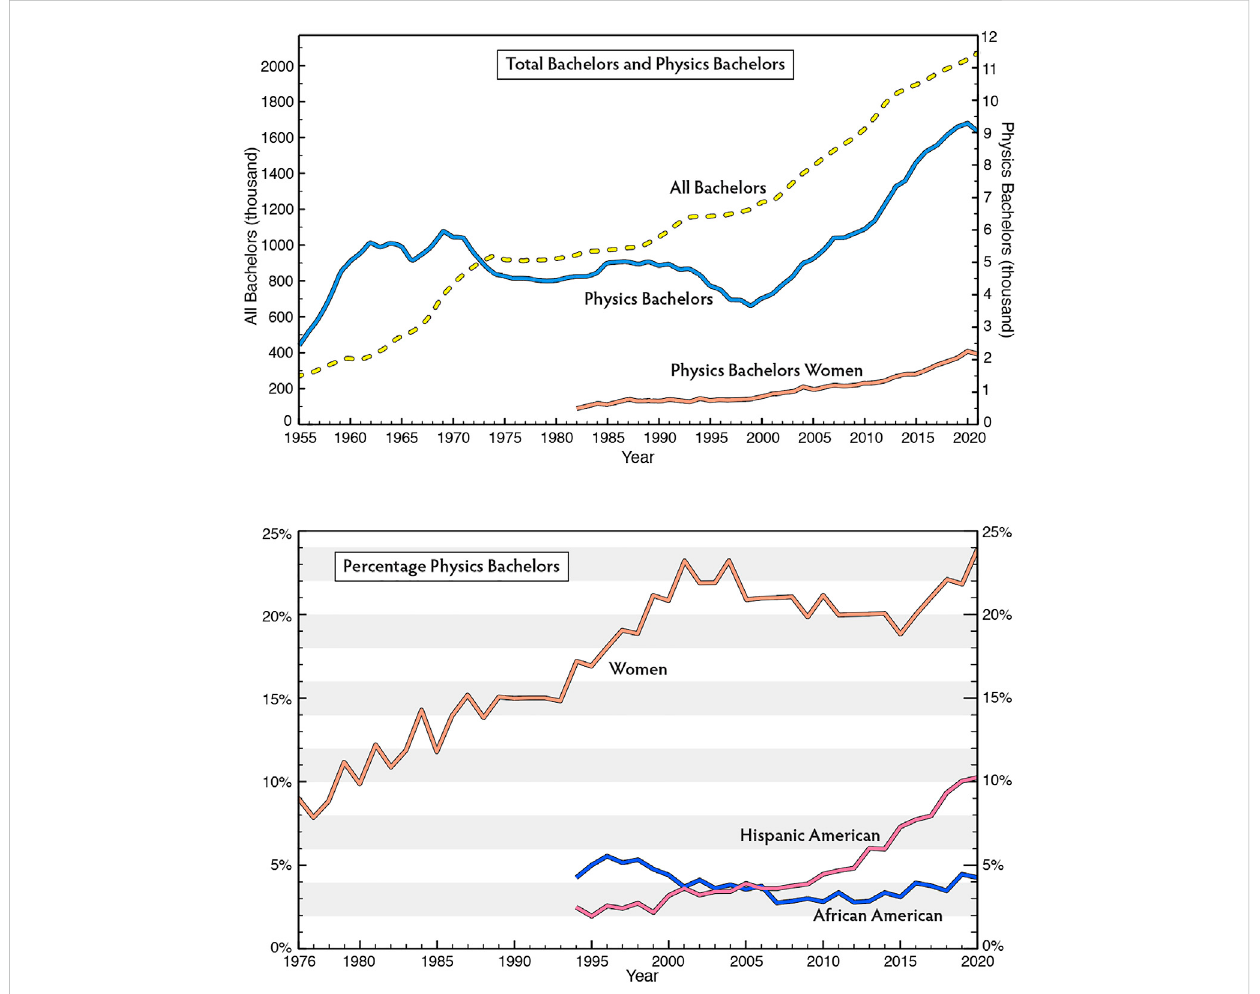
FIGURE 6 Top: Number of bachelor ’ s degrees (all topics) and physics bachelor ’ s degrees (1955 – 2021). Bottom: Percentage of Bachelor ’ s degrees in physics awarded to women, to HispanicAmericans and African Americans. Produced using data from the Statistical Research Center of the American Institute of Physics, see